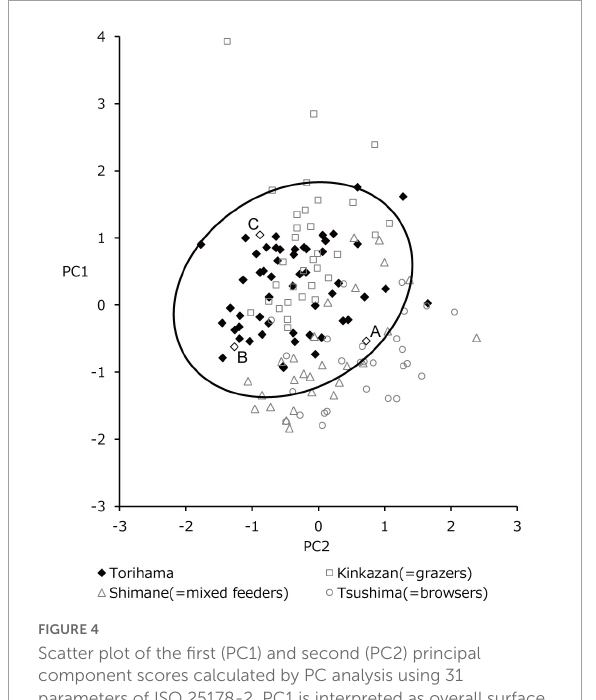
FIGURE4 Scatter plot of the first (PC1) and second (PC2) principal component scores calculated by PC analysis using 31 parameters of ISO 25178-2. PC1 is interpreted as overall surface roughness because the height and volume parameters had positive loads. PC2 presents the fineness of the microwear features because the parameters related to surface segmentation had positive loads: larger PC2 values indicate that surfaces are segmented into larger hills and dales. The 95% confidence range of Torihama deer is indicated by the bold line. Kinkazan, Shimane, and Tsushima deer are typical grazers, mixed feeders, and browsers, respectively.